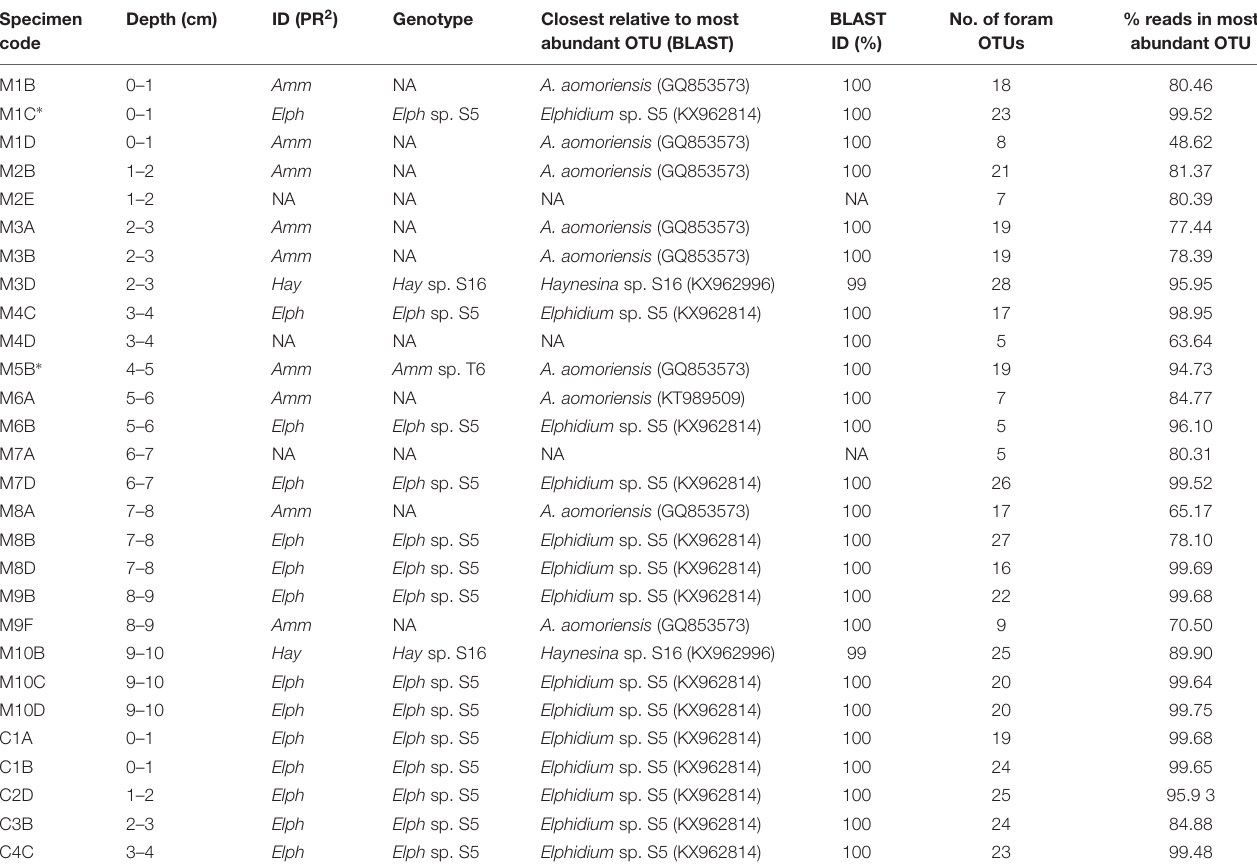
TABLE 1 | Foraminiferal specimens and their